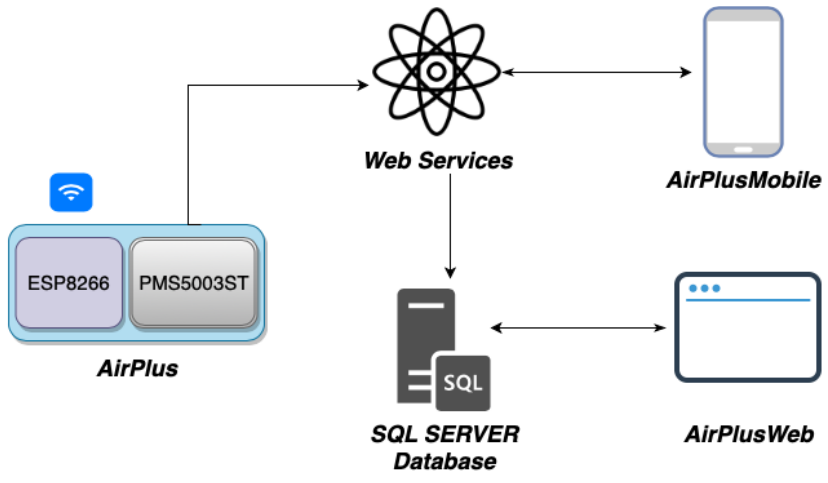
Figure 1. AirPlus system architecture.